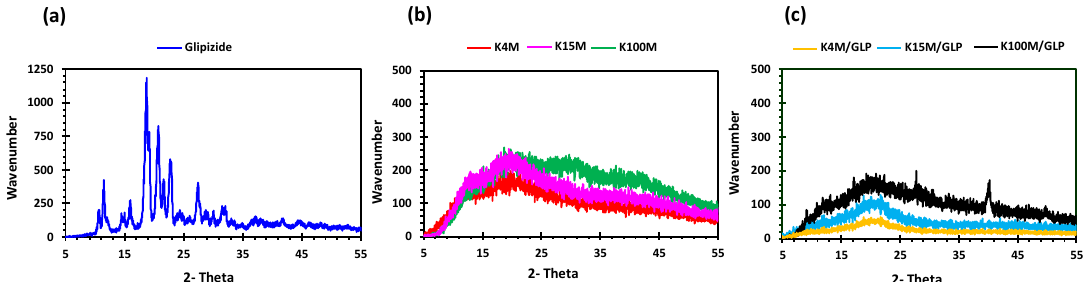
Figure 3. TGA profiles of ( a ) glipizide, ( b ) HPMC (K4M, K15M and K100M) and ( c ) K4M / GLP, K15M / GLP and K100M / GLP filaments.